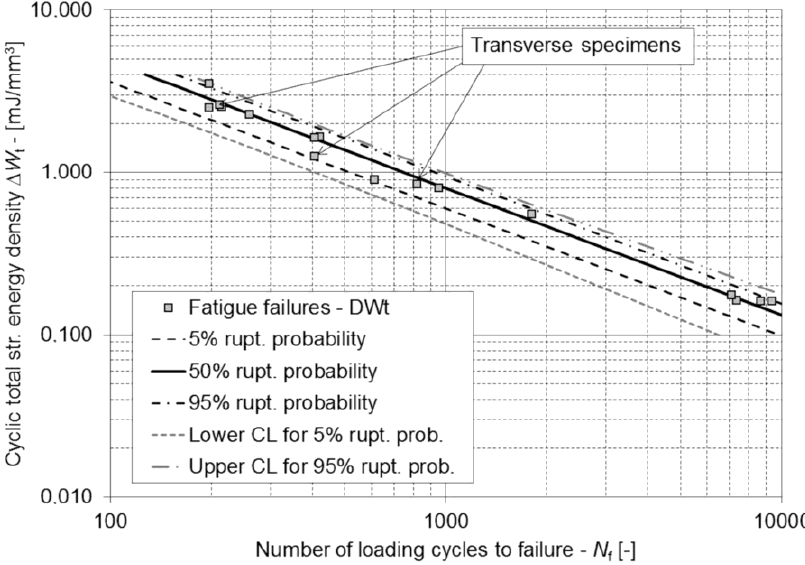
Figure 8. AZ31 fatigue-life curves for the total strain-energy density ∆ W t .